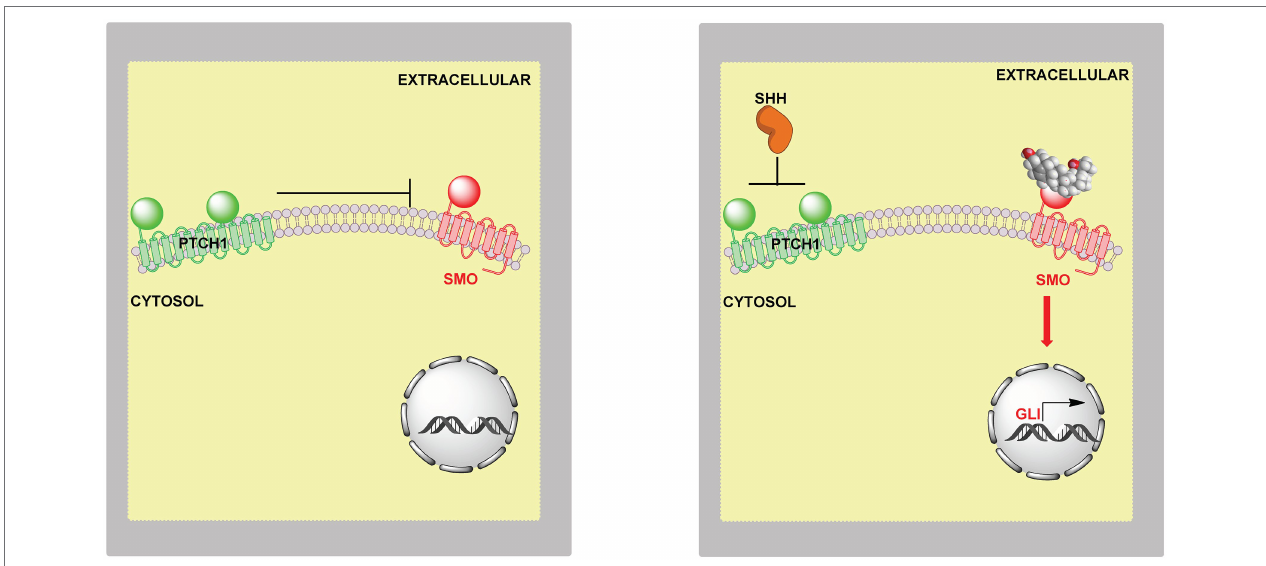
FIGURE 14 | Model of the involvement of oxysterols in Hh signalling. Left panel , in the absence of extracellular SHH or oxysterols PTCH1 inhibits SMO and the Hh signal is not transmitted across the membrane. Right panel , SHH relives the inhibition by PTCH1 on SMO and oxysterols bind to SMO leading to activation of GLI target